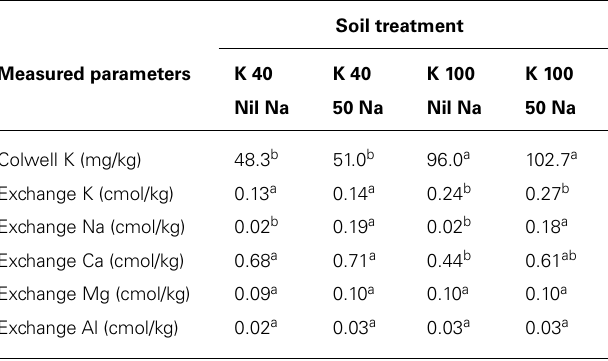
Means with different letters differ at P ≤